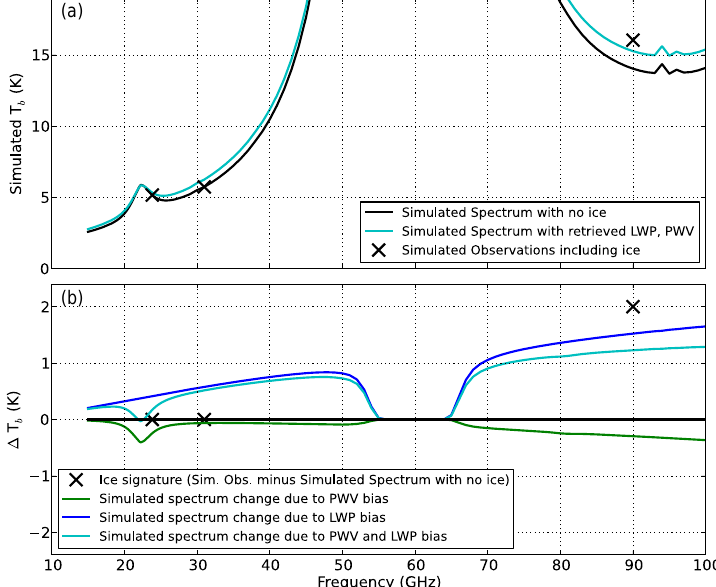
Figure 3. Panel (a) shows the simulated downwelling microwave radiance spectrum with no ice (black) and the simulated spectrum with the biased PWV and LWP obtained by the retrieval (cyan). Panel (b) shows the simulated data after subtracting the simulated spectrum with no ice. The effect of the biased LWP and PWV on the microwave spectrum are shown independently (blue and green lines, respectively) and combined (cyan line). The “X” marks show the simulated ice influence at 23.84, 31.40, and